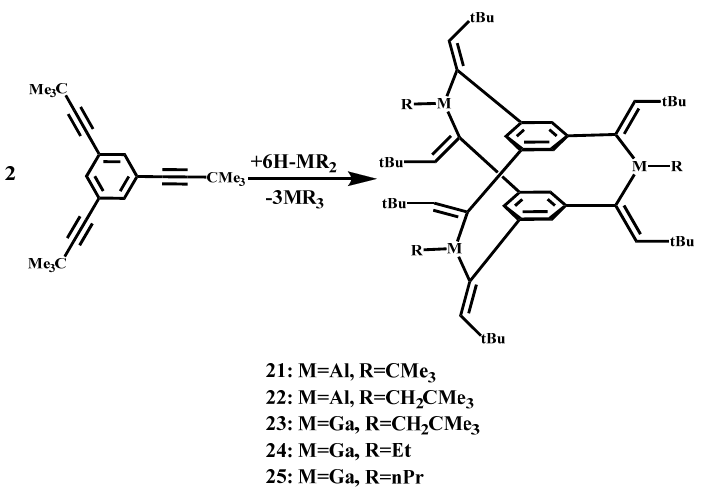
Figure 13. Synthesis of Aluminum-Bridged and Gallium-Bridged [3,3,3] cyclophanes derivatives.